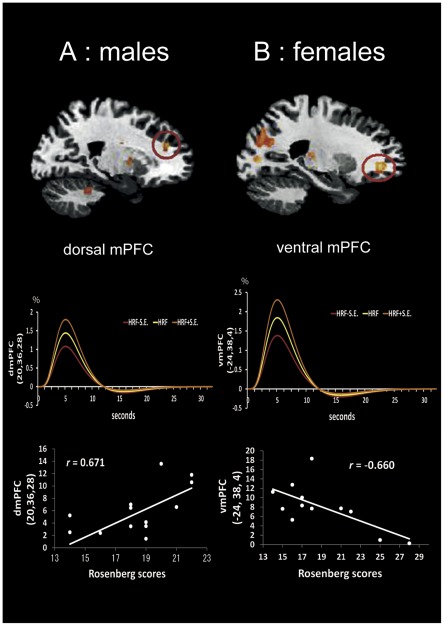
Relationship between Rosenberg scores and the differential activities of mPFC regions for IC vs C condition.(A) Upper; the red circle shows the differential activity in the right dmPFC for the IC vs. C conditions in males (x = 20). Middle; the hemodynamic response function (HRF) (yellow) averaged across subjects with standard errors (S.E.) recorded from dmPFC in males (y-axis: %, x-axis: seconds). Lower; scatter plot depicting the positive correlation between the difference in parameter estimates between the IC and C conditions in the right dmPFC and the Rosenberg self-esteem scores in males (y-axis: arbitrary unit). (B) Upper; the red circle shows the differential activity in the left vmPFC for IC vs. C conditions in females (x = −24). Middle; the HRF averaged across subjects with S.E. recorded from vmPFC in females (y-axis: %, x-axis: seconds). Lower; scatter plot showing the negative correlation between the difference in parameter estimates between the IC and C conditions in the left vmPFC and the self-esteem scores in females (y-axis: arbitarary unit). (p<0.005 uncorrected, for illustration).